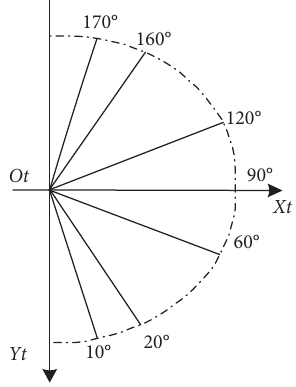
Figure 4: Situational factor extractions based on angle